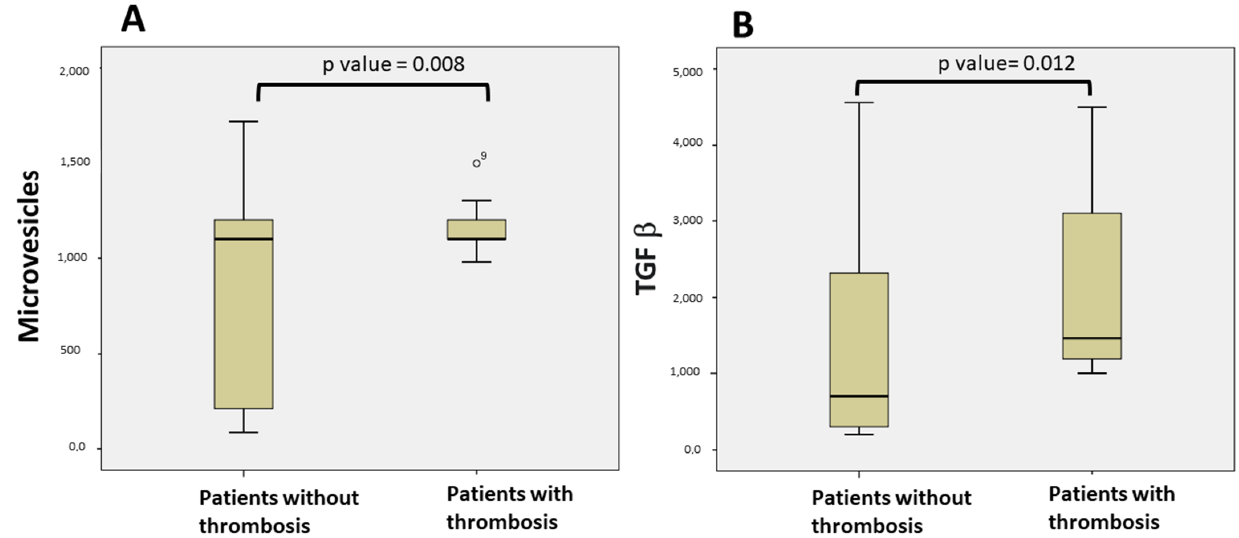
Figure 1. Comparison of patients with thrombosis and without thrombosis: ( A ) Microvesicle levels in patients with thrombosis and patients without thrombosis; ( B ) TGF- β levels in patients with thrombosis and patients without thrombosis. Table 2. MVs and serum levels of immunoregulatory cytokines (TNF- α , IL-10, IL-17, and TGF- β ) in: A. Whole cohort B. Patients with thrombosis C. Patients without thrombosis. Data are reported as “median (IQR)”.